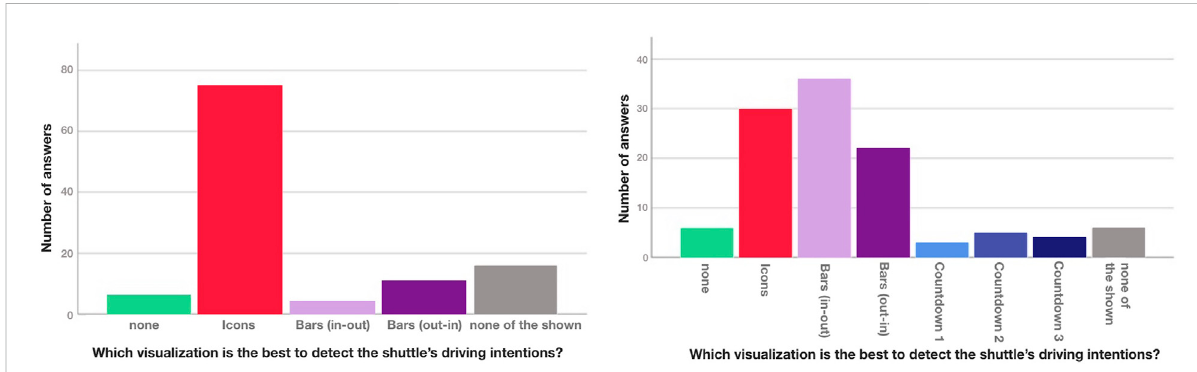
FIGURE 10 Preferred eHMI for detecting the shuttle ’ s intentions at Crossing A and B.